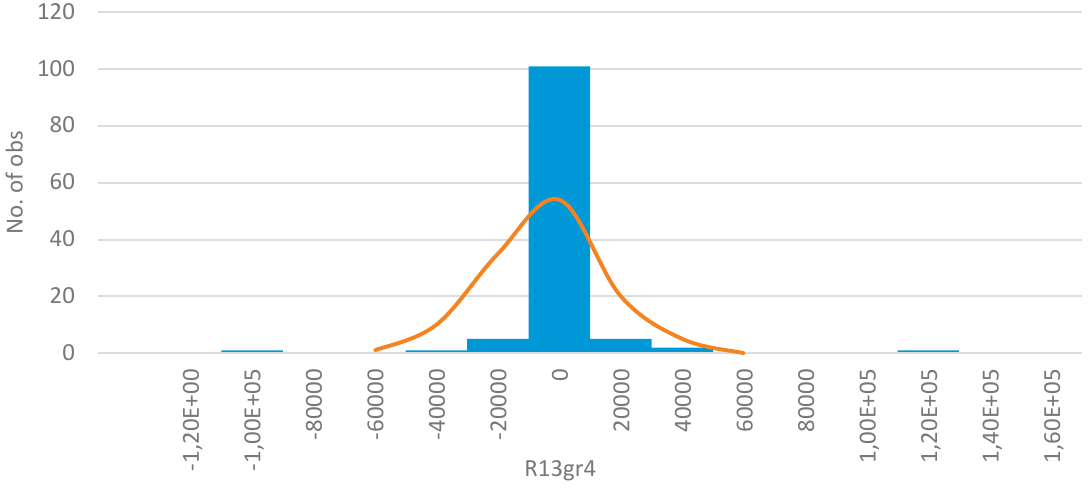
(cid:94)(cid:381)(cid:437)(cid:396)(cid:272)(cid:286)(cid:855)(cid:3)C(cid:258)(cid:367)(cid:272)(cid:437)(cid:367)(cid:258)(cid:410)(cid:286)(cid:282)(cid:3)(cid:271)(cid:455)(cid:3)(cid:410)(cid:346)(cid:286)(cid:3)(cid:258)(cid:437)(cid:410)(cid:346)(cid:381)(cid:396)(cid:400)(cid:3)(cid:271)(cid:258)(cid:400)(cid:286)(cid:282)(cid:3)(cid:381)(cid:374)(cid:3)(cid:69)(cid:17)(cid:104)(cid:3)(cid:282)(cid:258)(cid:410)(cid:258)(cid:3)(cid:449)(cid:349)(cid:410)(cid:346)(cid:3)(cid:410)(cid:346)(cid:286)(cid:3)(cid:346)(cid:286)(cid:367)(cid:393)(cid:3)(cid:381)(cid:296)(cid:3)